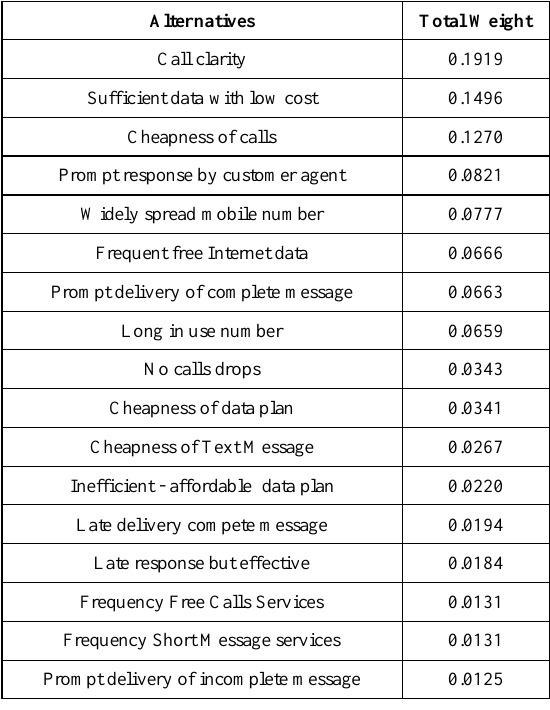
Table 4. 2: Customer retention alternatives and